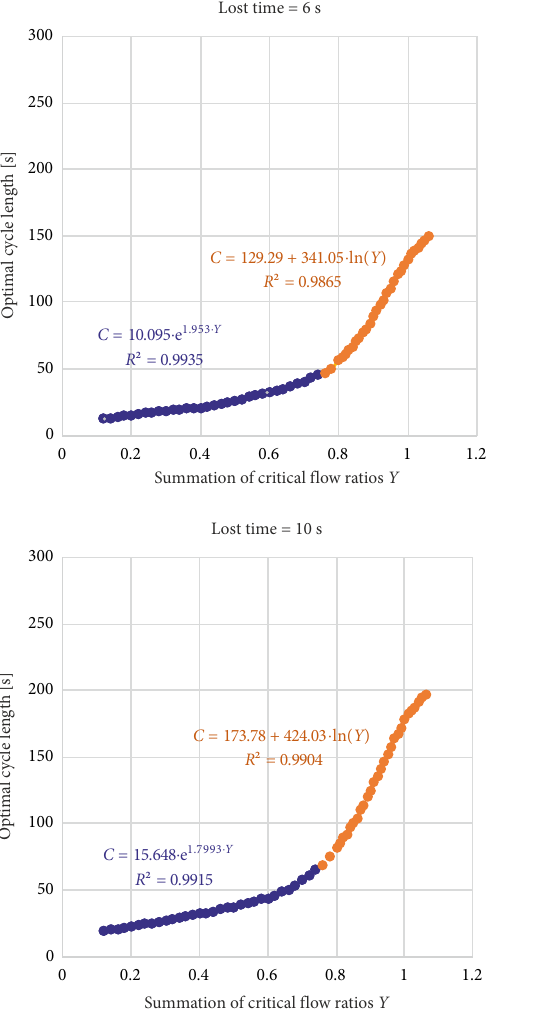
Figure 3. Optimal cycle length at different values of Y for lost times between 6 and 12